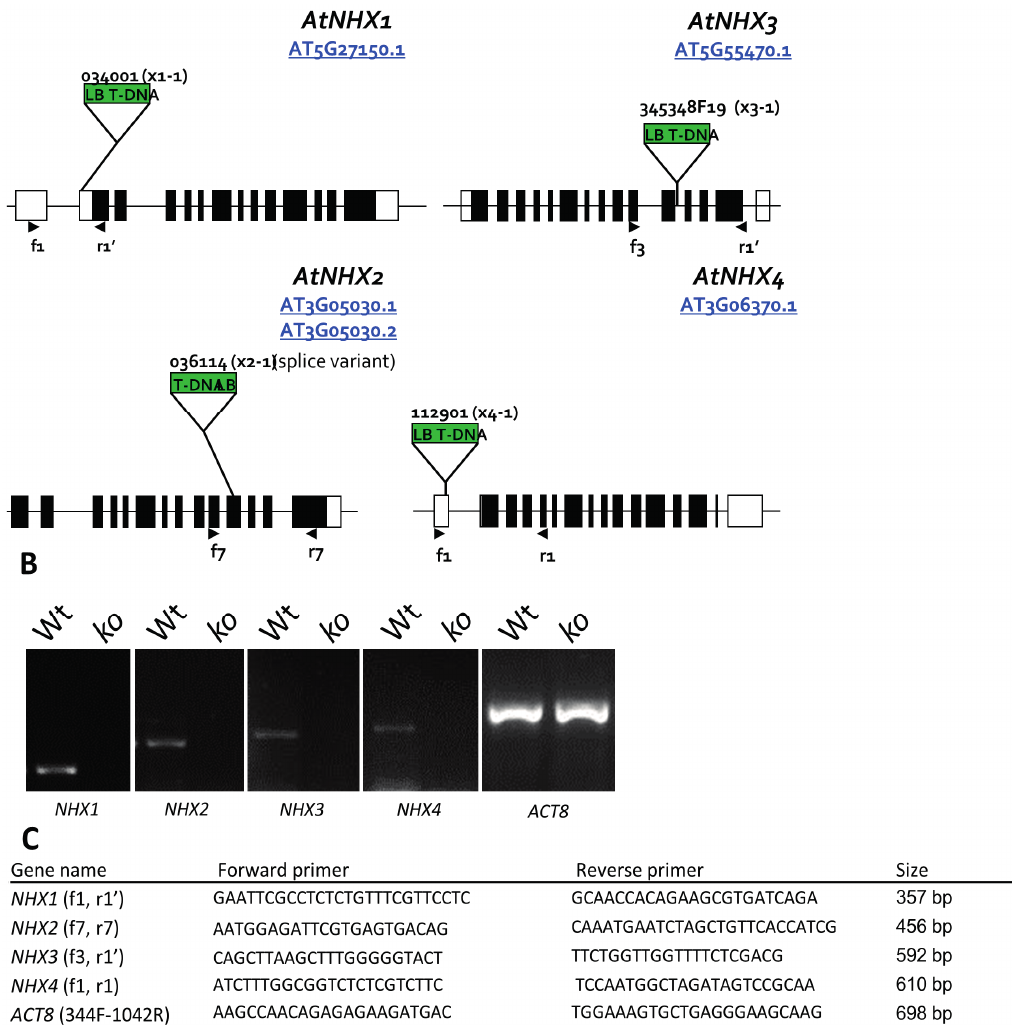
Figure A1. Genetic maps of NHX T-DNA insertions used in generating nhx1nhx2nhx3nhx4 ( A ); rt-PCR shows no expression of NHX1 , NHX2 , NHX3 , NHX4 in nhx1nhx2nhx3nhx4 ( B ); primers used for verifying gene expression are shown in the table ( C ).